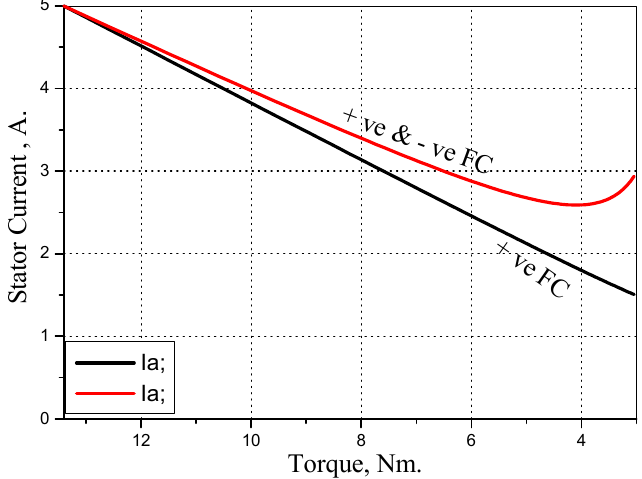
Figure 6. DC field current effect on constant power speed range (CPSR).